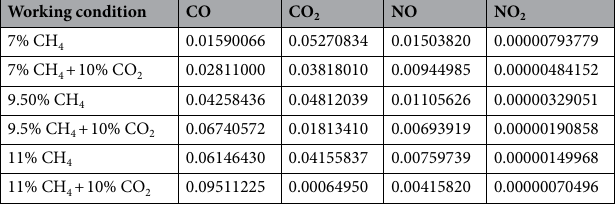
Table 3. Mole fractions of gas products under different working